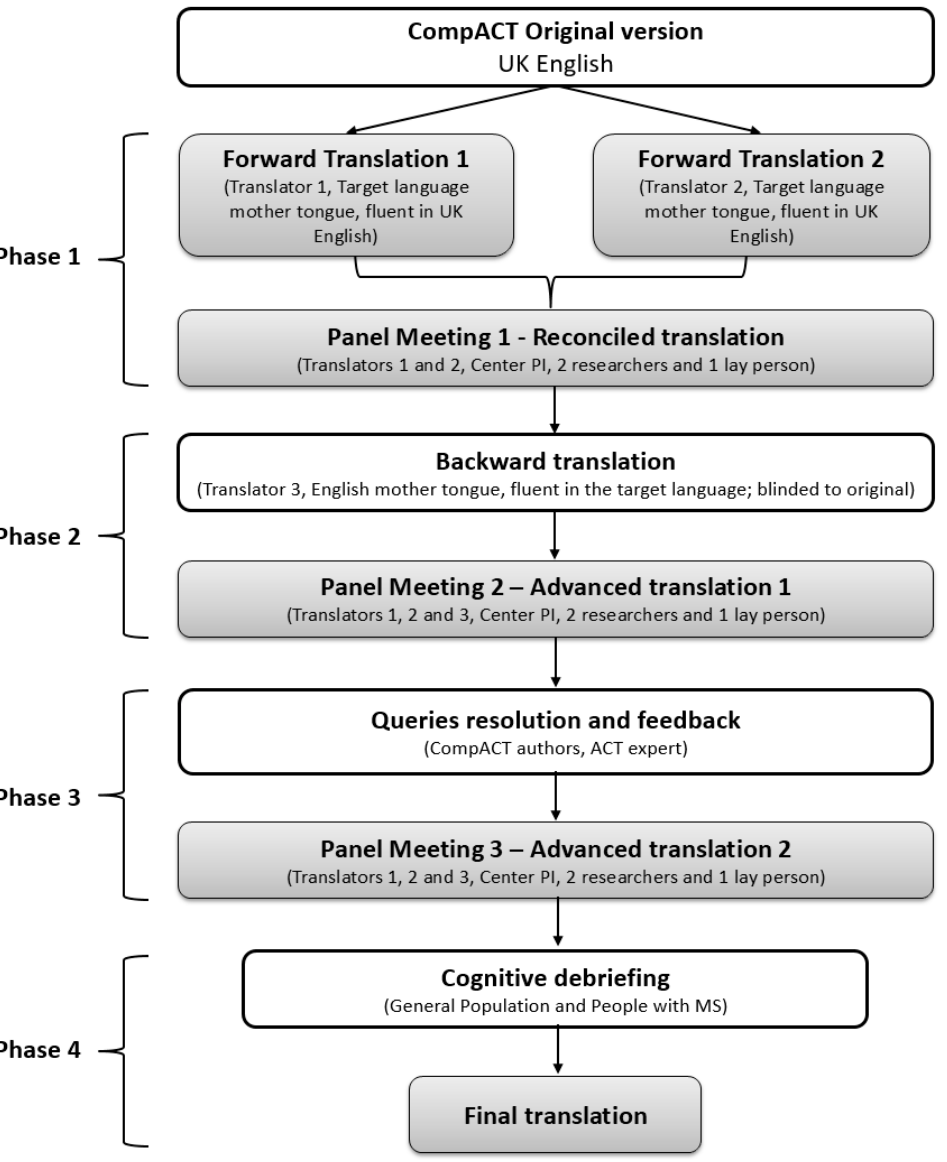
Figure 1. Translation process. MS is multiple sclerosis; PI is principal investigator; ACT is acceptance and commitment therapy.